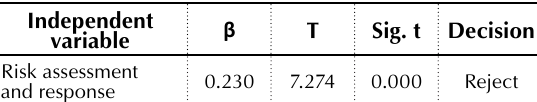
Table 5. Results of a simple linear regression analysis to test the fourth sub-hypothesis ( H04 )